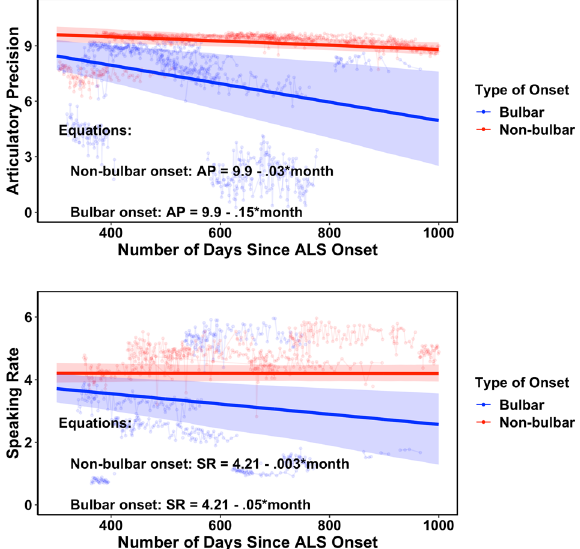
Fig. 2 Articulatory precision (AP) and speaking rate (SR) scores as a function of number of days since date of ALS onset. AP was extracted from data collected for the participants ’ full duration of enrollment, whereas for SR, the initial 45 days were excluded to avoid rate increases which were observed in healthy controls, possibly due to familiarization with the sentences. Note: The thin lines and points show the observed data of a random sample of 35 participants. The dark red thick line represents the expected trajectory for all nonbulbar participants. The dark blue thick line represents the expected trajectory for all bulbar participants. The expected trajectories were obtained from the fi xed-effects estimates from the growth curve models. The shaded areas indicate the bootstrap 95% con fi dence bands for the expected trajectories. In the equations: 1 month = 30